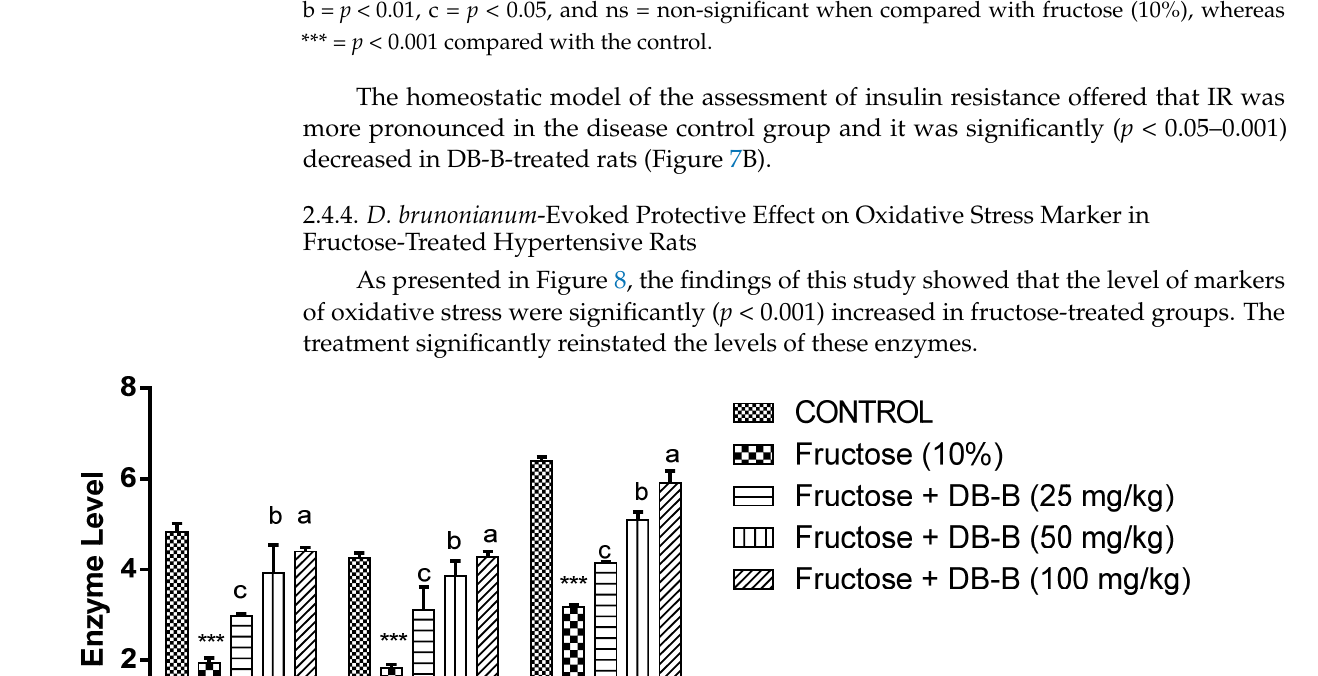
Figure 8. DB-B-elicited restoration of enzymes of the defense system altered by fructose All results were analyzed statistically using two-way ANOVA followed by the Bonferrani test. Data is presented as mean ± SEM of n = 5. Herein, *** represents p < 0.001 in comparison with the control group, whereas a = p < 0.001, b = p < 0.005, and c = p < 0.05 in relation to the fructose (10%) group. DB-B = butanolic fraction of D. brunonianum.